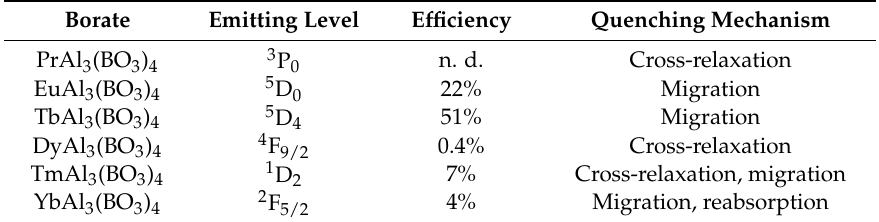
Table 3. Summary of the luminescence features of the investigated